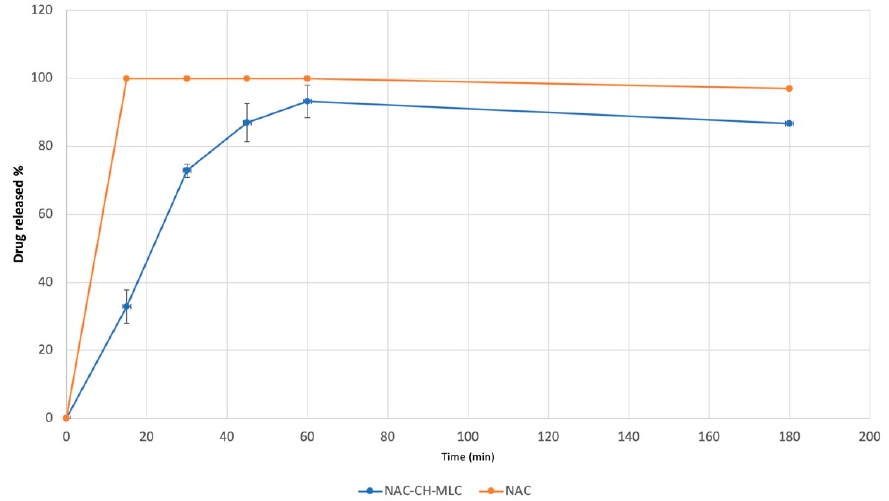
Figure 6. N-acetylcysteine release profile from NAC-CH-MLC and NAC dissolution profile in NaCl 0.9%.